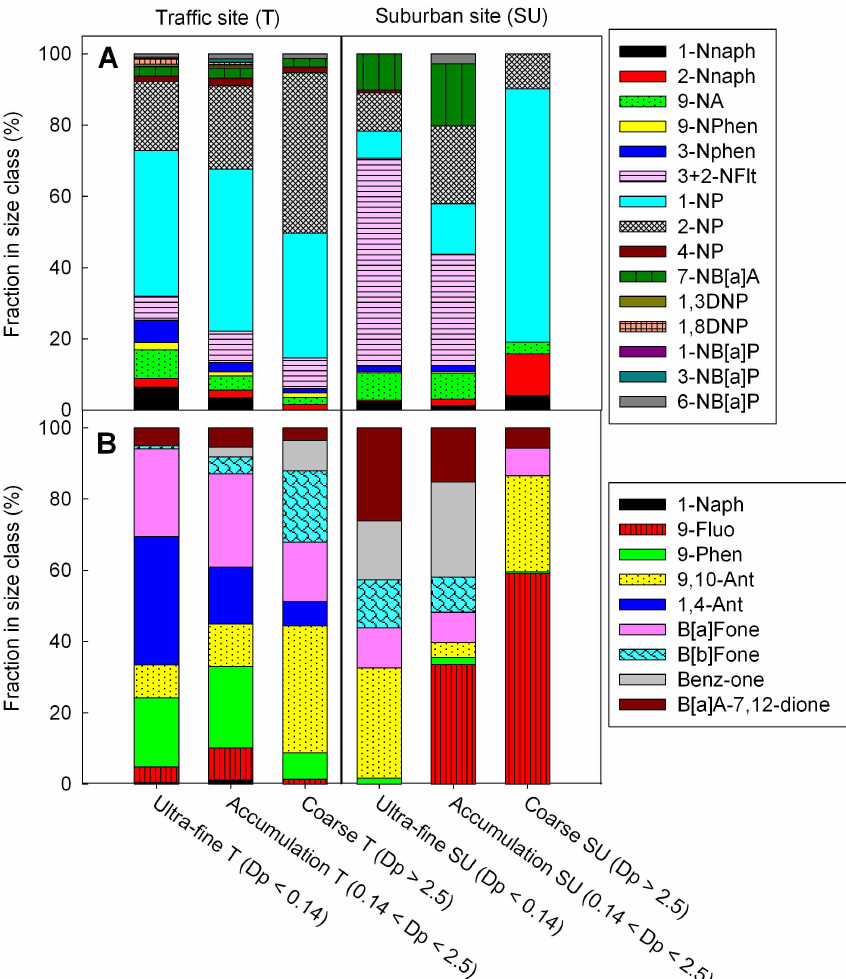
Fig. 2. NPAH (A) and OPAH (B) concentration profiles (%) according to the different particle size classes and to the sampling site (traffic and